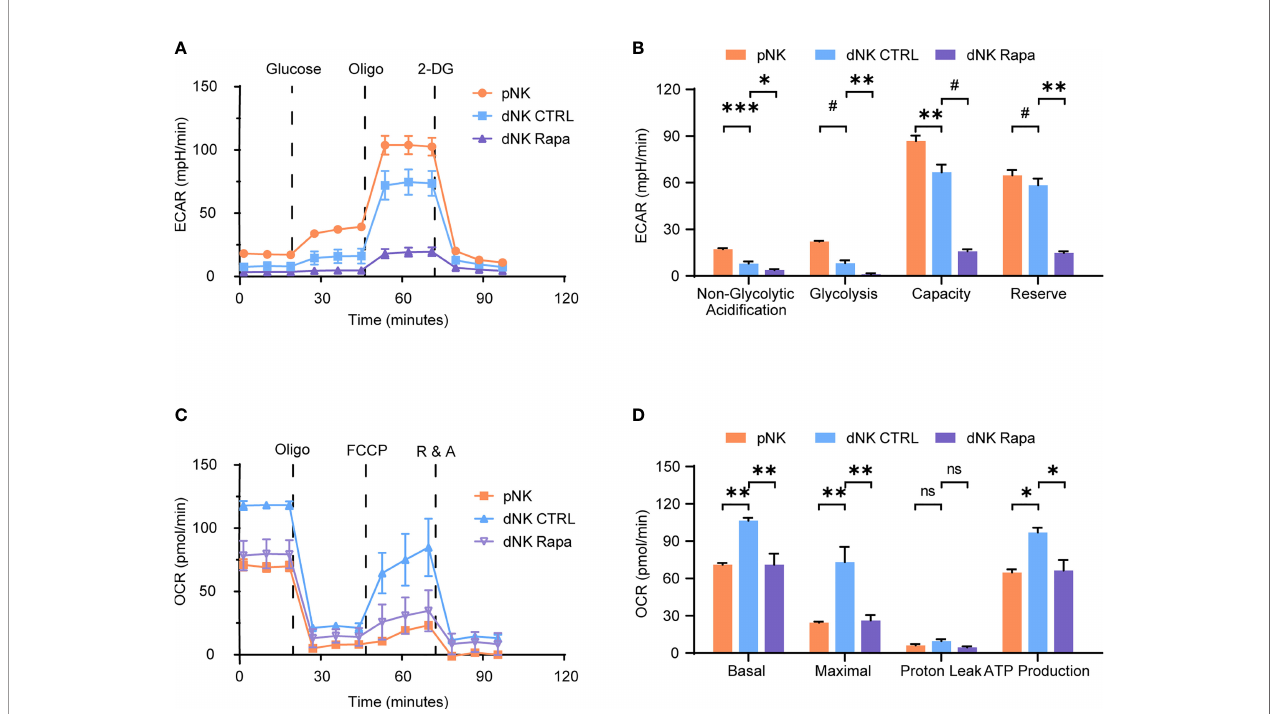
FIGURE 1 | Characteristics of decidual natural killer cells glucose metabolism. (A – D) Analyses of extracellular acidi fi cation rate (ECAR) and oxygen consumption rate (OCR) in puri fi ed human peripheral NK cells (pNK) and decidual NK cells (dNK) after cultured for 24 h supplemented with IL-15 as a survival factor. ECAR of NK cells with the sequential addition of glucose (10 mM), the mitochondrial ATP synthase inhibitor oligomycin (oligo, 0.5 µM), and the glucose analog 2-deoxyglucose (2-DG, 100 mM) were assessed in real time (A) . Real-time changes of OCR in NK cells with successive addition of oligomycin (oligo, 1 µM), the mitochondrial uncoupler FCCP (1 µM), and inhibitors of mitochondrial electron transport chain complex I and III, rotenone (500 nM) and antimycin A (500 nM) (R&A), were measured (C) . Also, rapamycin (Rapa, 20 nM) was used to treat dNK to evaluate mTORC1 activity on its metabolism (A – D) . (n = 4-5 for (A – D) , one-way ANOVA with a Dunnett post- test). ns, not signi fi cant; * P < 0.05, ** P < 0.01, *** P < 0.001; and # P <